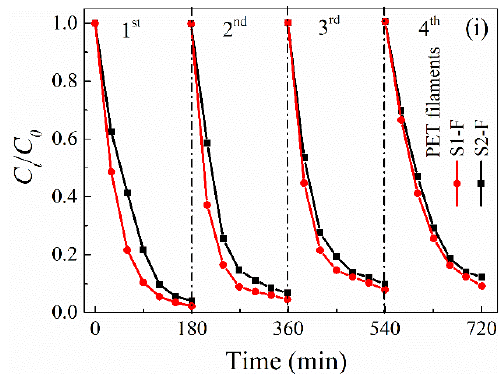
Figure 5. Photo-degradation of methylene blue (MB) dye solutions by ( a – d ) the as-modified PET filaments and ( e – h ) the as-prepared TiO 2 powders under UV and visible light irradiation; ( i ) cyclic photo-degradations of MB solutions by both types of PET filaments under UV irradiation.